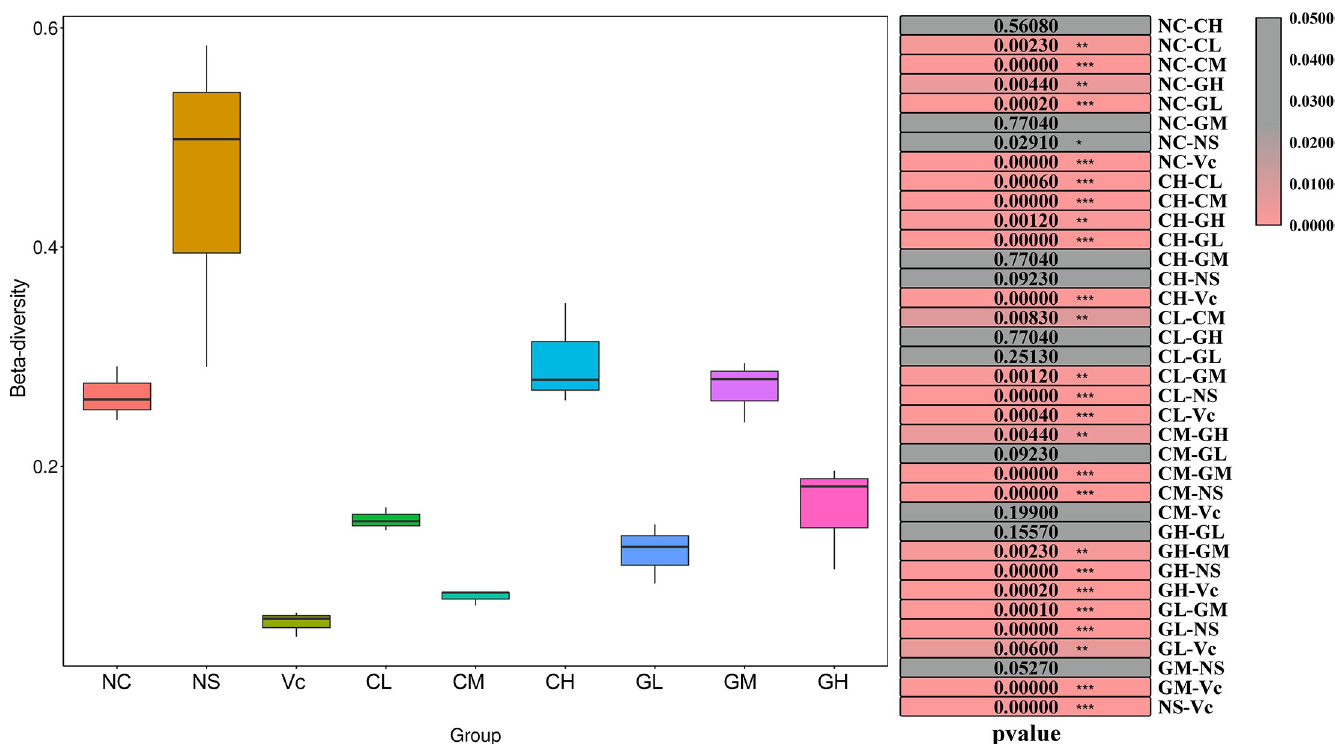
Fig 3. β -diversity of different groups. The different colored boxes on the left represent different groups. The right side of the figure shows the p-value between two comparisons. The β -diversity was calculated by Wilcox test. NC: Normal control; NS: Negative control; Vc: Positive control; CL, CM, CH represents low-, middle-, high- concentration cow whey protein intervention group, respectively. GL, GM, GH represents low-, middle-, high-concentration goat whey protein intervention group, respectively.